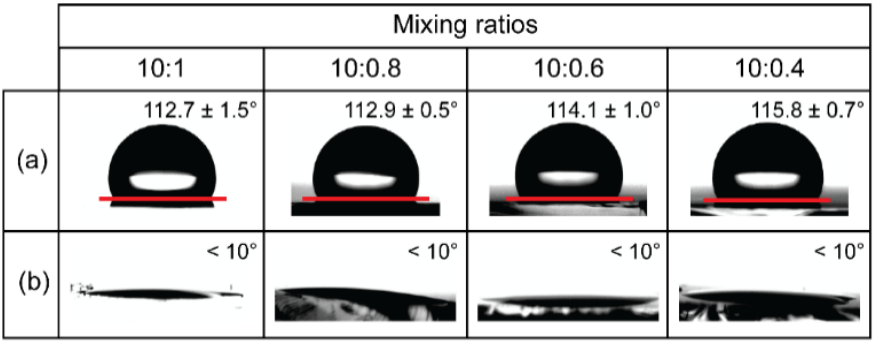
Figure 2. Characterization of PDMS substrates with different mixing ratios. Results of water contact angles measurements on PDMS substrates: ( a ) Pristine PDMS. ( b ) Oxygen plasma treatment of the PDMS. Five measurements were taken and averaged.